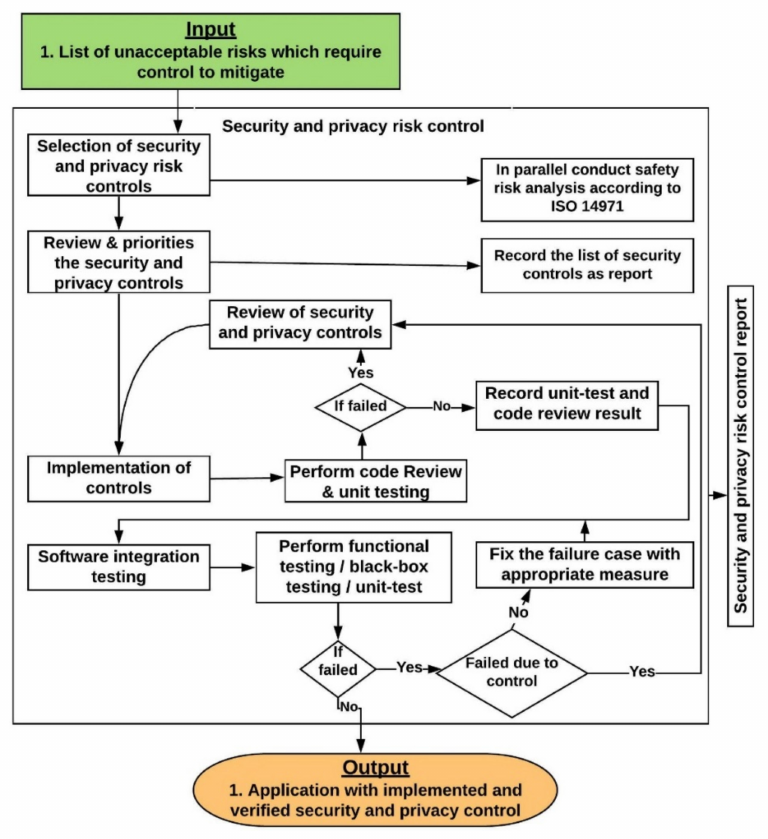
Figure 10. Selection and implementation process of security and privacy risk